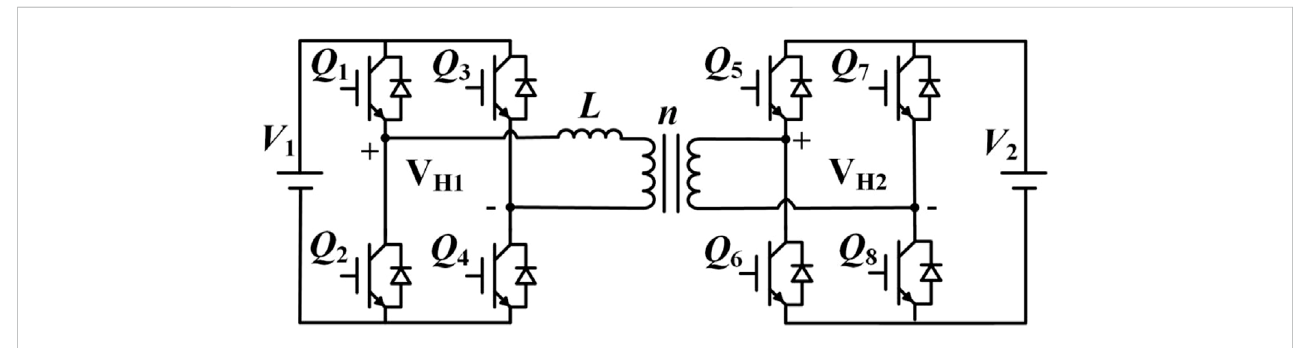
FIGURE 2 The typical topology of DAB